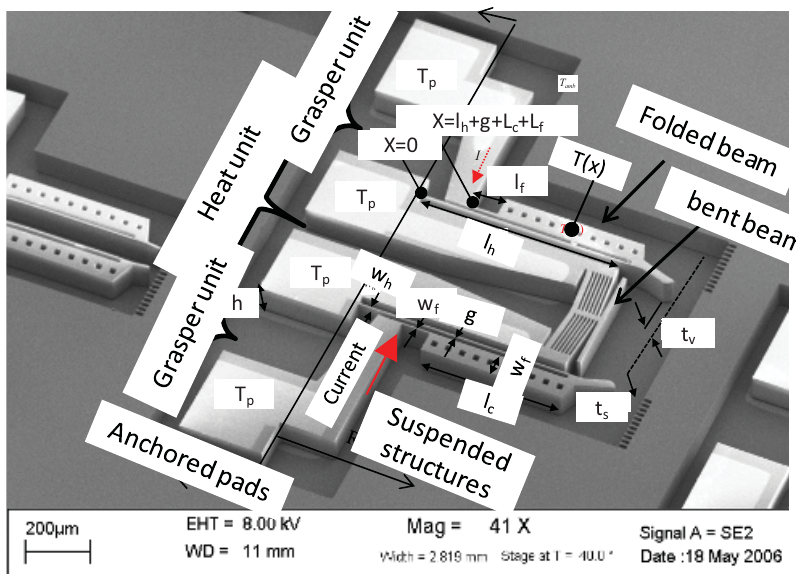
Figure 2. The E-T actuator comprises a grasping mechanism and a heating